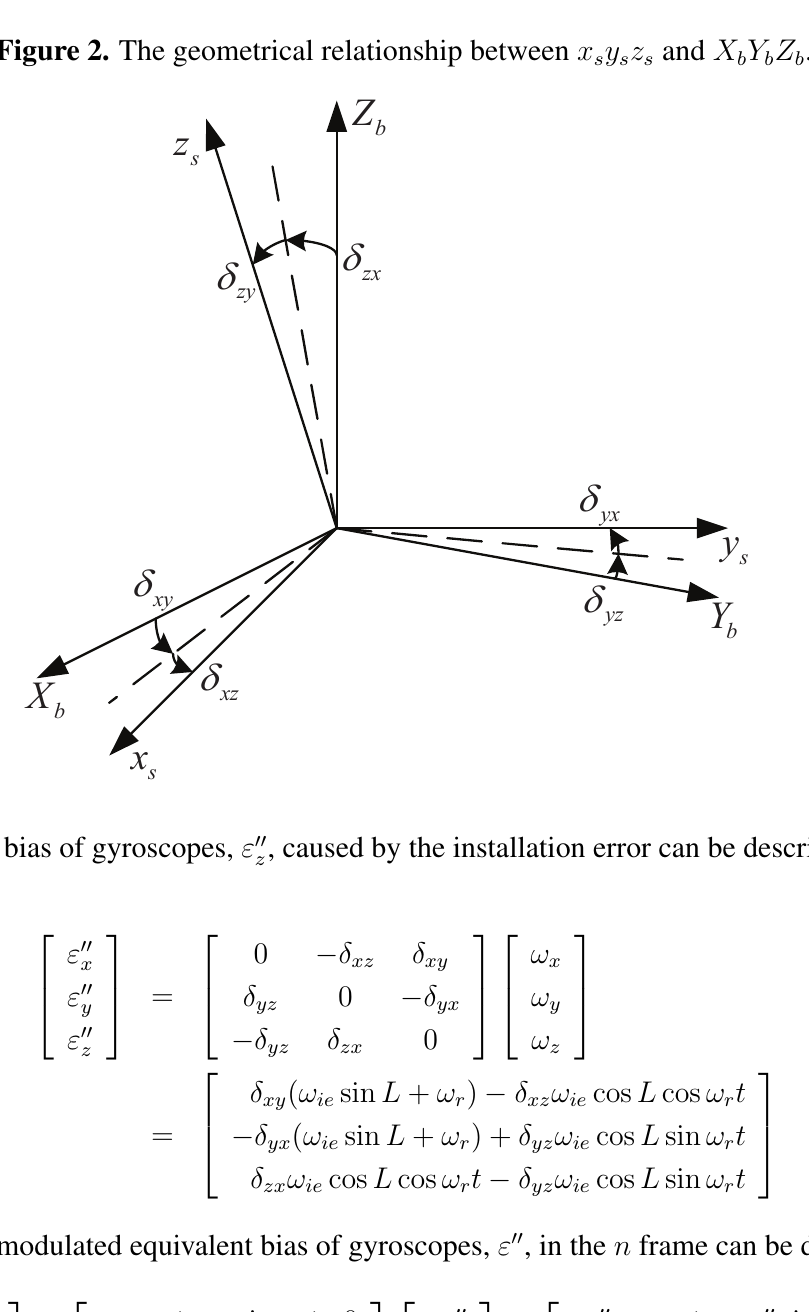
Figure 2. The geometrical relationship between x